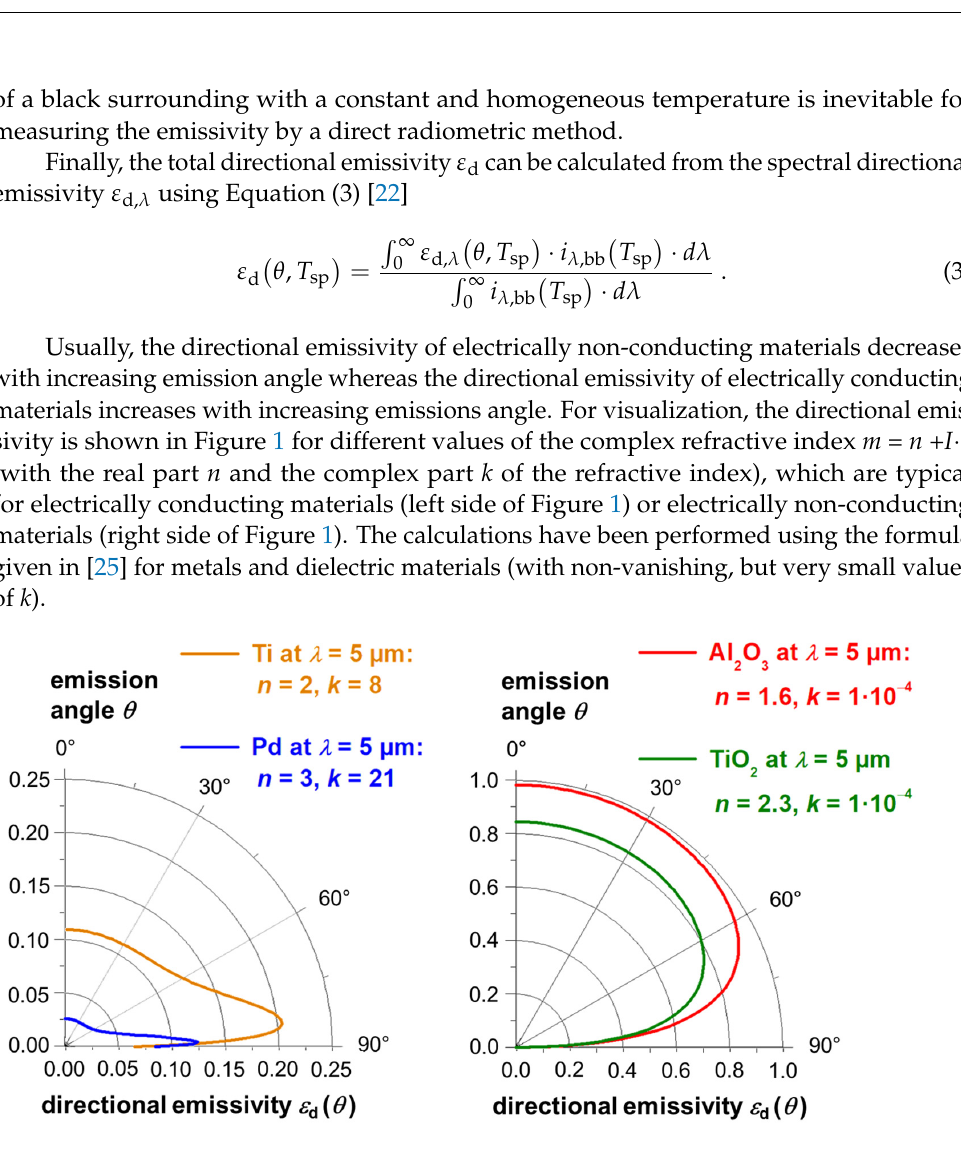
Figure 1. Directional emissivity at ambient temperature as a function of the emission angle between 0° to 90° (relative to the surface normal) for electrically conducting materials (on the left side) and electrically non-conducting materials (on the right side). The calculations have been performed for selected materials with the respective refractive indices taken from [26], assuming opaque specimen with sufficed thicknesses.